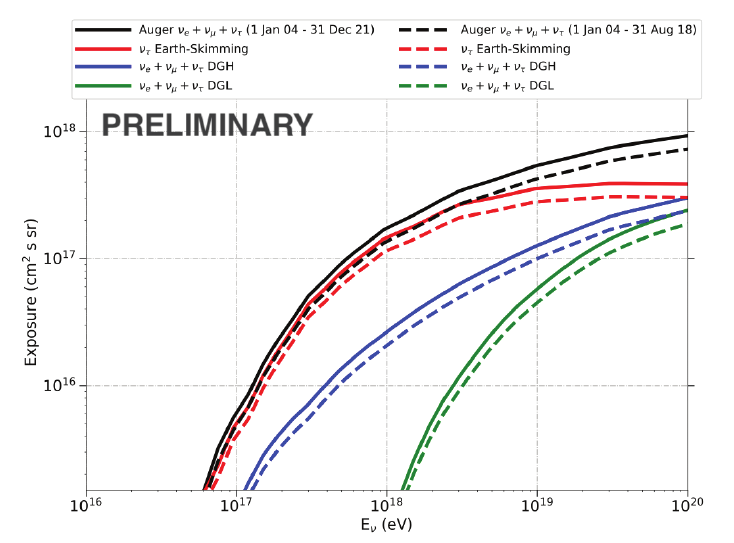
Figure 3. Exposure of the 1500m SD array to UHE neutrinos as a function of energy, for the three search channels (ES, DGH, DGL) and the data period 1 January 2004 to 31 December 2021 (solid lines); for comparison, also the corresponding exposure for the data period from [16] is included (dashed